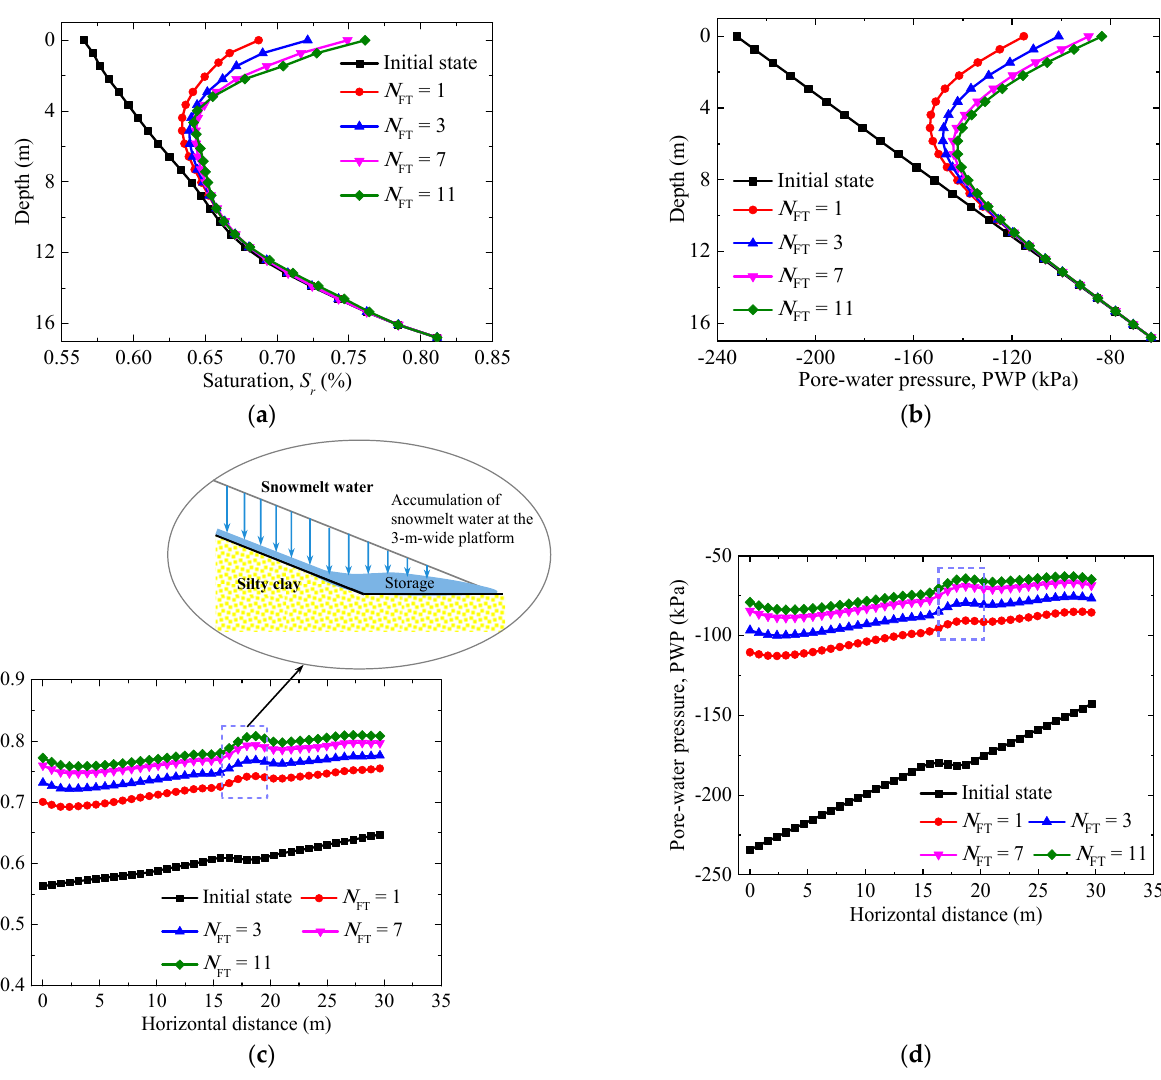
Figure 19. Effect of freeze-thaw cycles ( N FT ) on the ( a ) the degree of saturation profile at L1; ( b ) the PWP profile at L1; ( c ) the degree of saturation profile at L2; and ( d ) the PWP profile at L2.